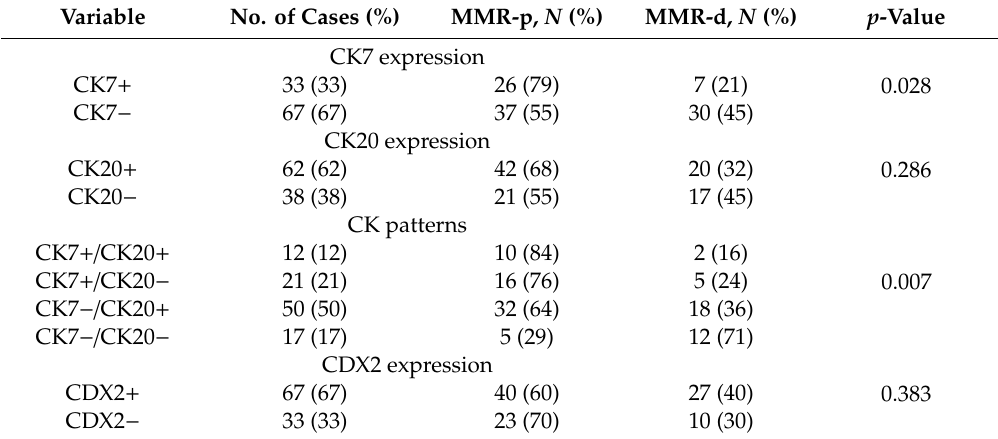
Table 2. Relationship between expression of phenotypic markers and mismatch repair deficiency status in the 100 small bowel adenocarcinomas investigated.